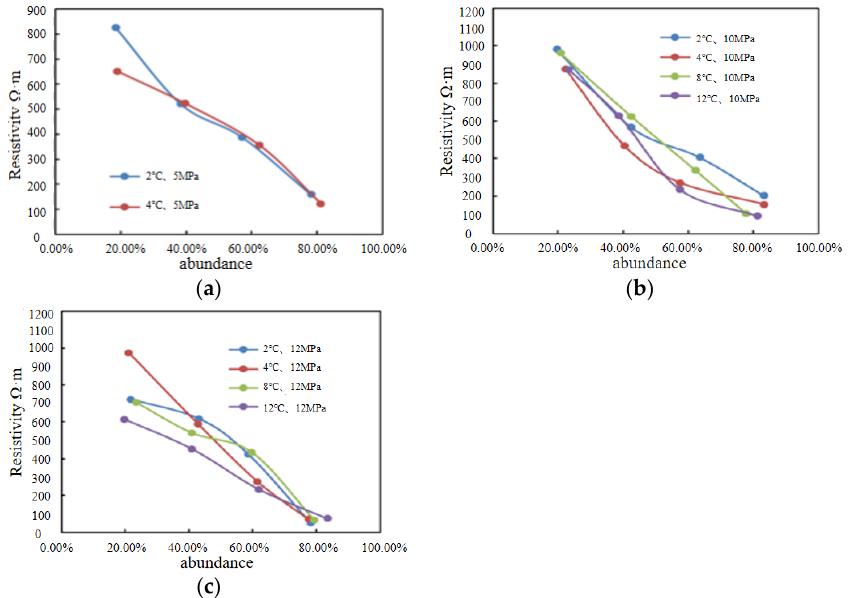
variation rules, as shown in Figure 7.